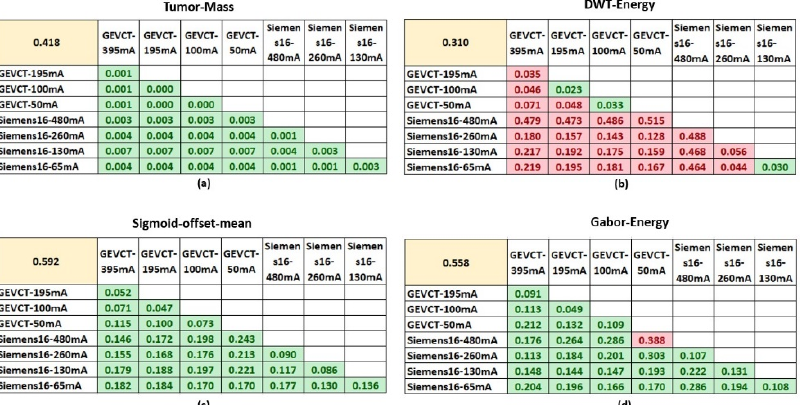
Figure 2. Comparisons of biological and noise signals. The four tables show the comparison of biological and noise signals for each of the 4 non-redundant and informative features. The top left yellow highlighted cell in each table shows the average value of biological signal for that respective feature. The average values of noise signal generated from each specific pairwise setting comparison are shown in the tables. Cells highlighted in green had a p -value < 0.05 using the two-sample t -test, whereas cells highlighted in red had a p -value > 0.05. ( a – d ) are the comparisons for the features, Tumor-Mass, DWT-Energy, Sigmoid-offset-mean and Gabor-Energy, respectively. For Tumor-Mass, the biological signal distribution had a mean value of 0.418 and the noise signal between the pairs of imaging settings had a distribution with mean values no